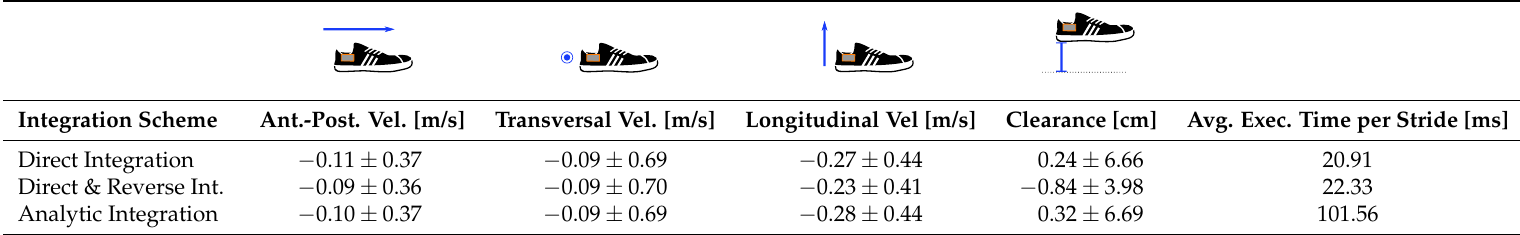
Table 3. Mean ± standard deviation of the error distribution for the estimated velocity/clearance as well as average execution time for all three double integration schemes with optimal parameter configurations and integration endpoints involving cyclic boundary conditions like the zero-velocity